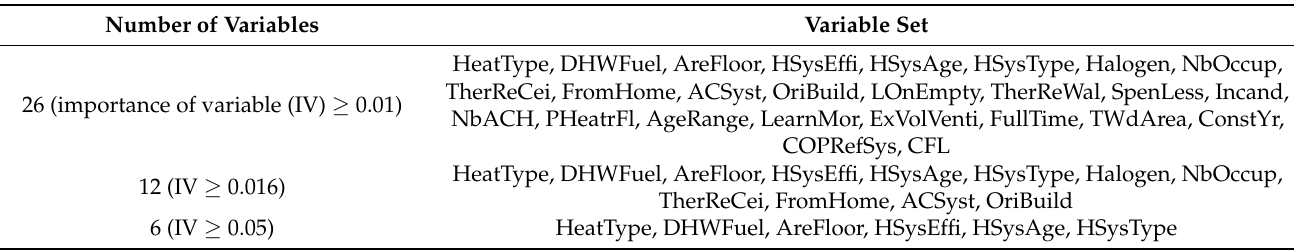
Table 2. Variable selected for predicting electricity consumption.